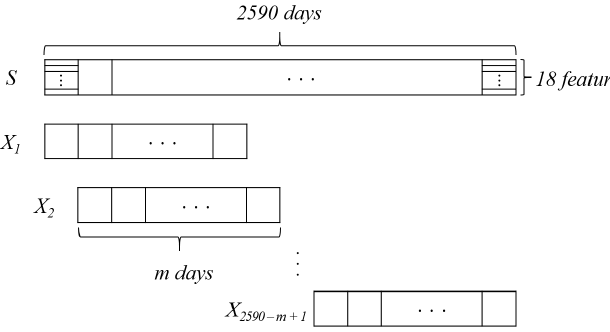
Figure 4. Data preprocessing. A total of 2590 − m + 1 sequence data are generated from the whole dataset of 2590 days if m consecutive days are analyzed to predict the next Bitcoin